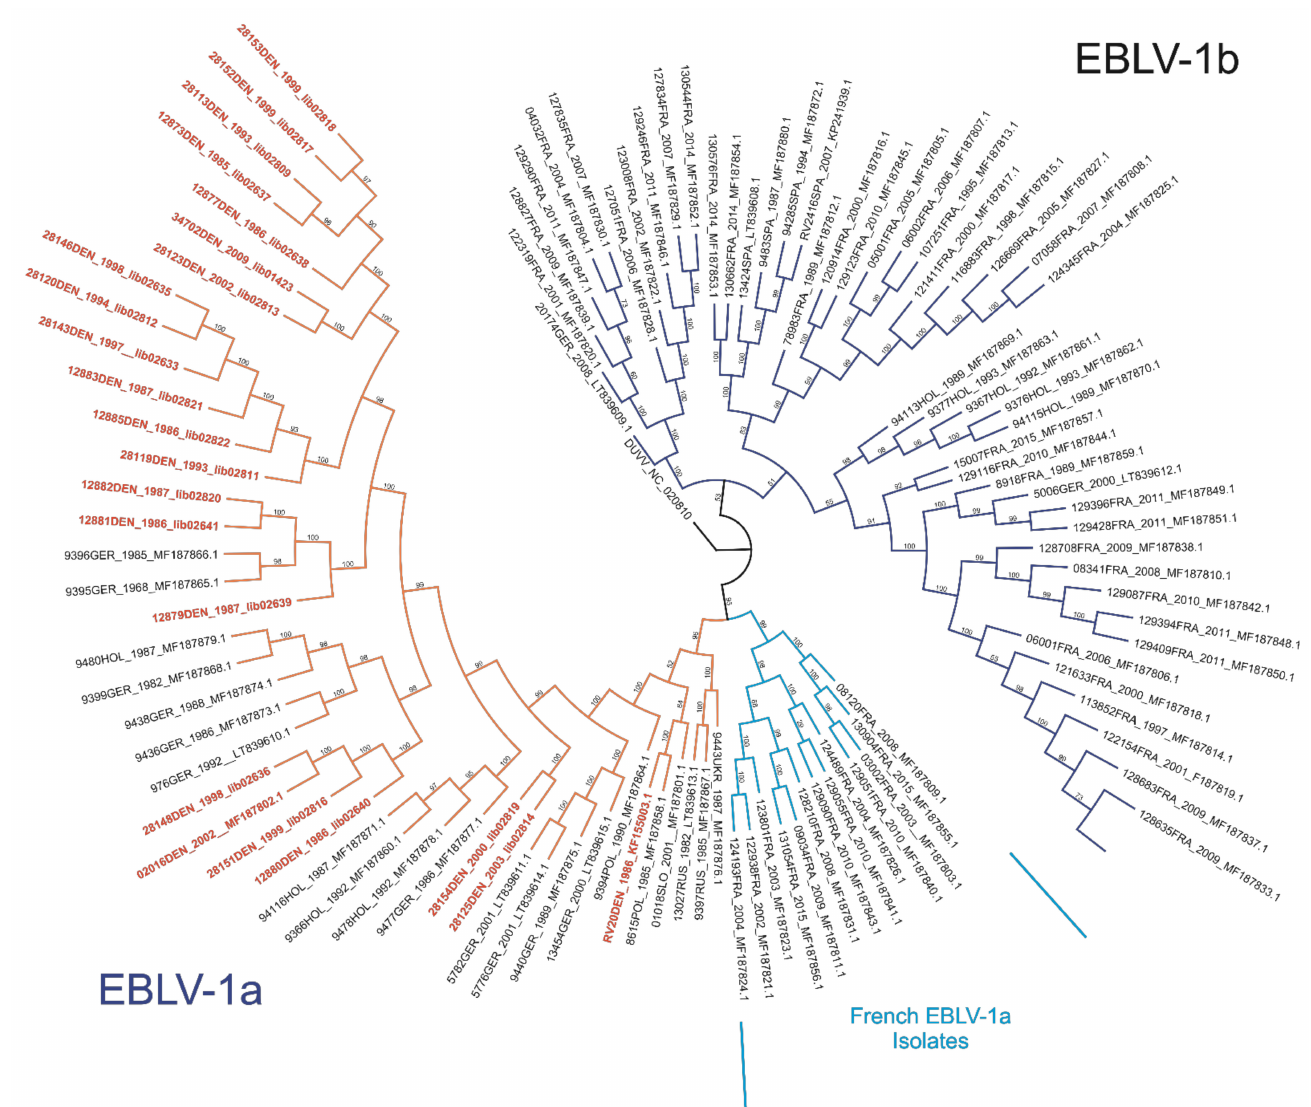
Figure 1. Circular phylogenetic tree of 112 EBLV-1 full-genome sequences originating from 9 European countries including Spain, France, Poland, Slovakia, Russia, Ukraine, Germany, The Netherlands and Denmark using isolate DUVV_Ref_Seq_NC_020810 as defined outgroup. Ultrafast bootstrap values (percentage) are indicated at each branch. Sublineage EBLV-1a (orange branches) and 1b (dark blue branches) are clearly separated. The distinct cluster formed by French isolates within the EBLV-1a sublineage is indicated in turquoise. EBLV-1 full genome sequences from Denmark are highlighted in